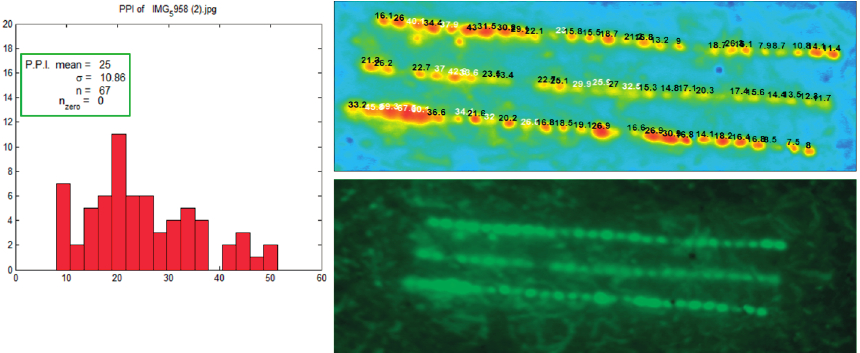
Figure 2. Visualization and uniformity of pores created with microneedles. Calcein fluorescent dye was applied on microporated skin for visualization. Fluropore software generated histogram shows uniformity of pores.